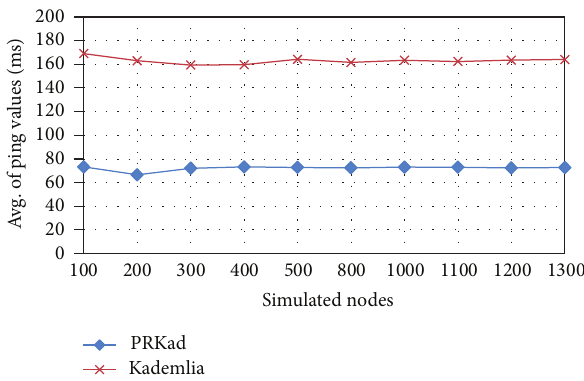
Figure 9: Average of RTT values for nodes with successful